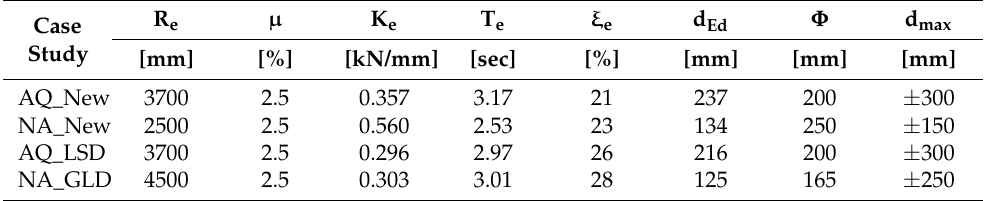
Table 3. Geometric characteristics and main design parameters of the isolation system at the CLS.